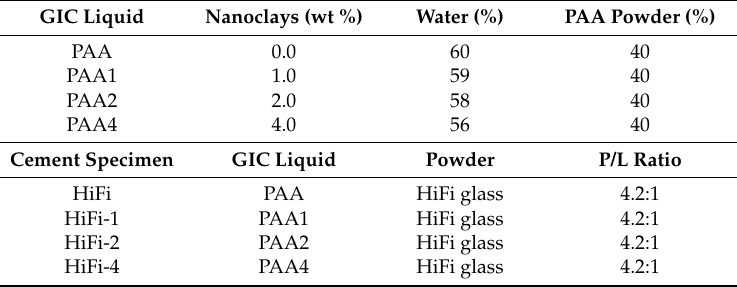
Table 2. Schematic presentation of polymer-nanoclay liquid formation and subsequent formation of glass ionomer